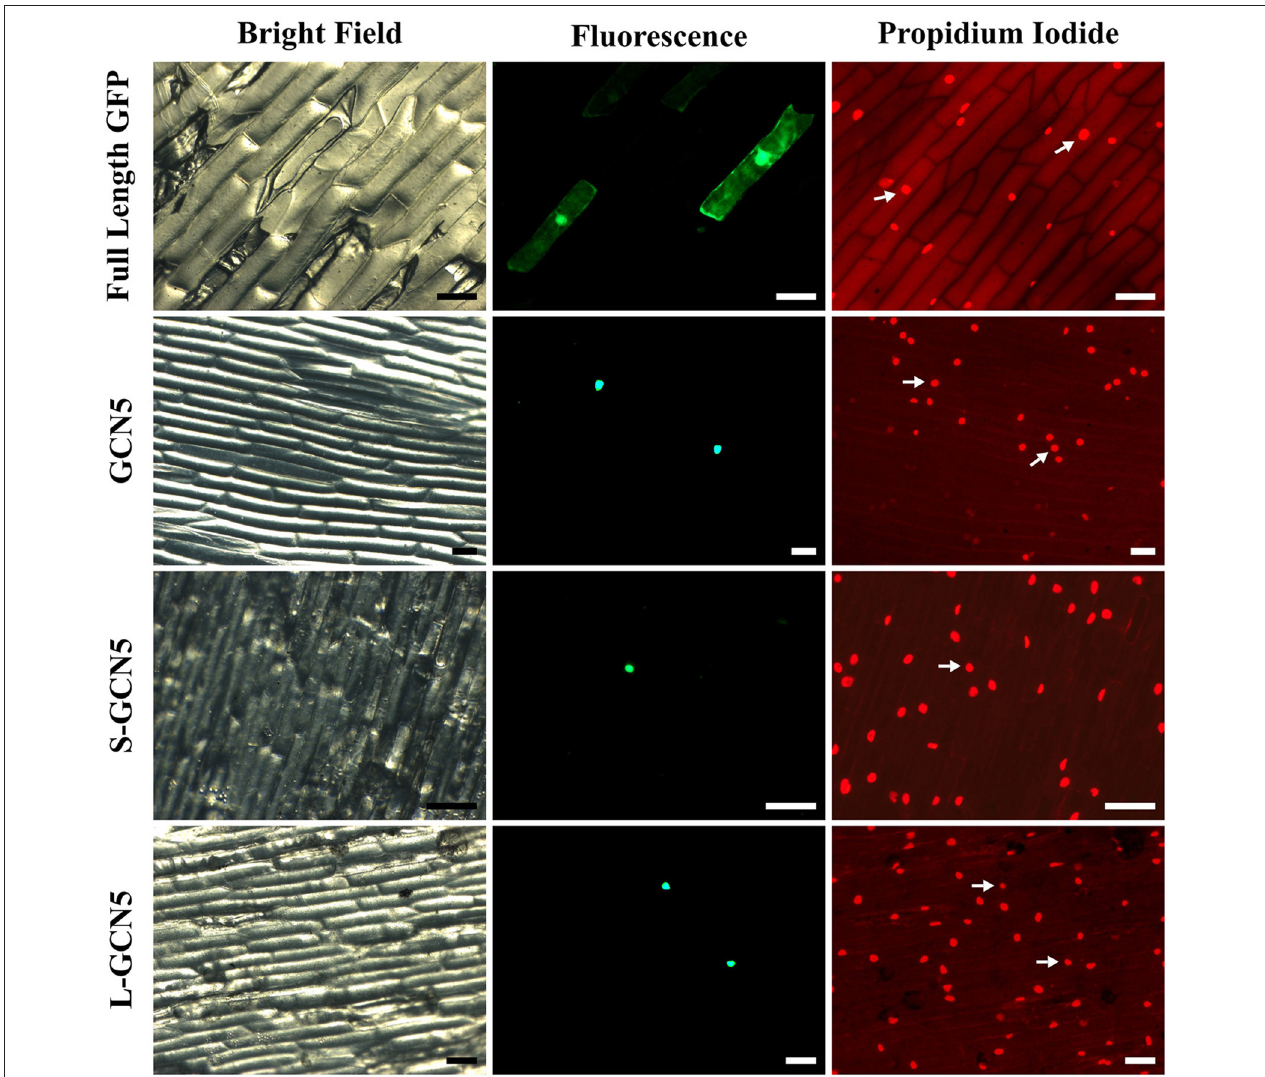
FIGURE 4 | All BdGCN5 isoforms localize to the nucleus. GFP was N-terminally tagged to GCN5 , S-GCN5, and L-GCN5 using the pAVA321 localization vector. Untagged GFP, as well as the N-terminally GFP-tagged constructs, were used for particle bombardment of onion scale cells. Images of bright field, fluorescence (GFP filter) and following propidium iodide staining are presented. Arrows indicate nuclei detected under both propidium iodide and GFP filters. Scale bar = 100 µ